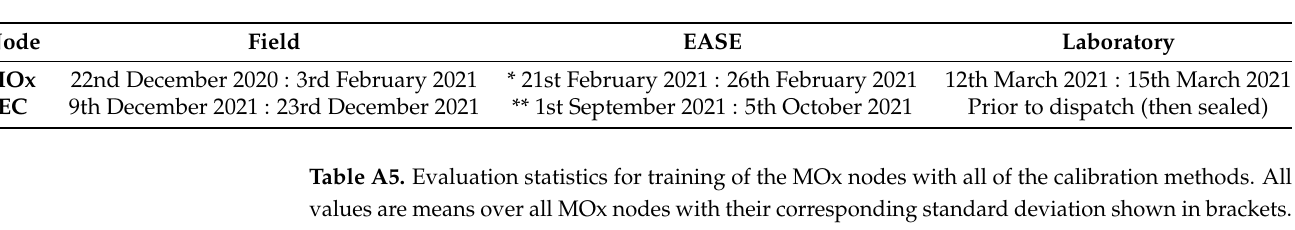
Table A4. Summary of calibration period dates. * EASE separated into 2 batches, ** EASE separated into 7 batches, tested alongside other nodes.